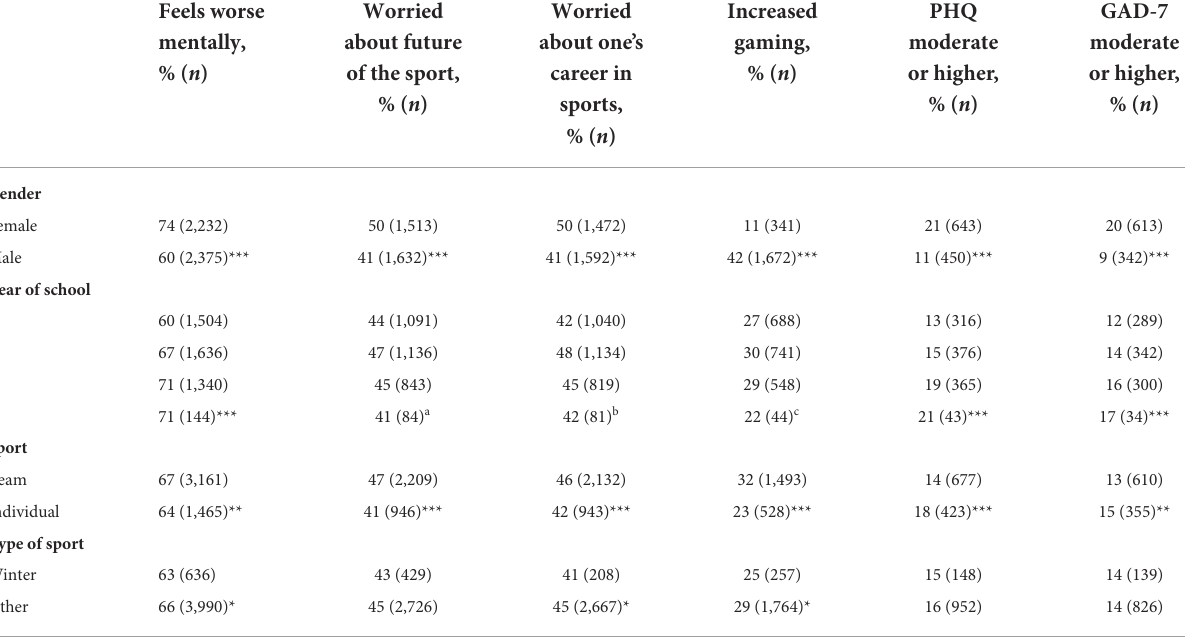
TABLE 1 Variables associated with psychological distress and self-reported change in gaming behavior in high school athletes ( N = 7,025).